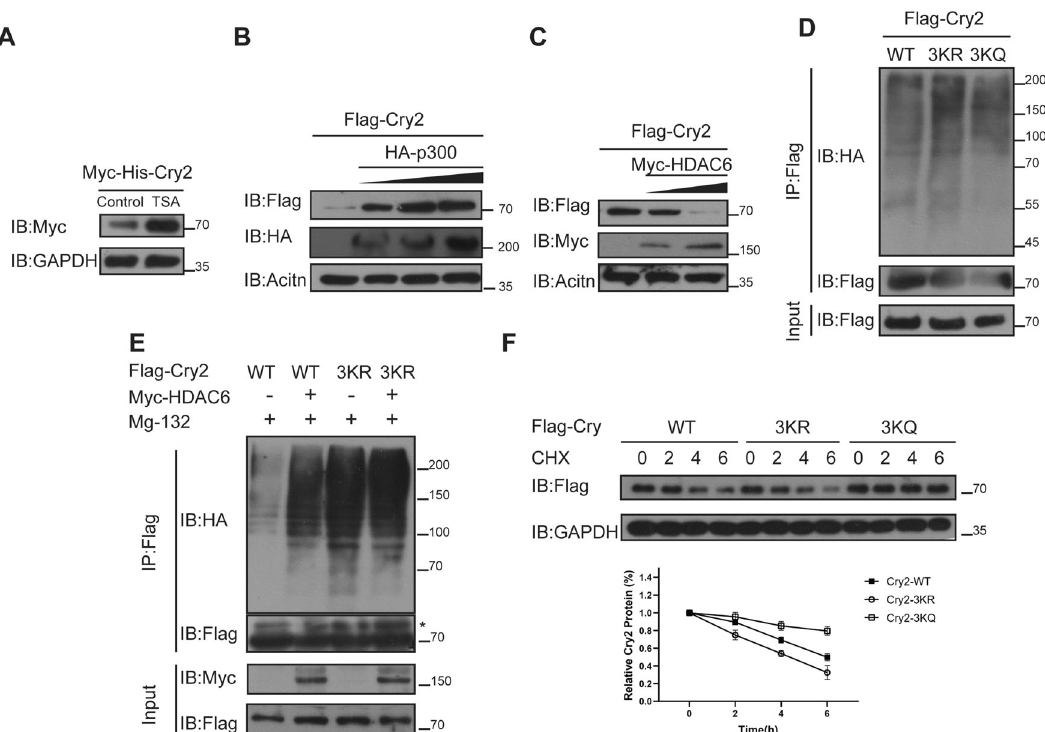
Fig. 4 Acetylation leads to Cry2 stabilization. A TSA promoted Cry2 stability. B p300 promoted Cry2 stability in a dose-dependent manner. C HDAC6 impaired Cry2 stability in a dose-dependent manner. D Cry2 – 3KR increased poly-ubiquitination of Cry2. E HDAC6 could not alter the ubiquitination of Cry2 – 3KR. F Half-lives of Cry2 and